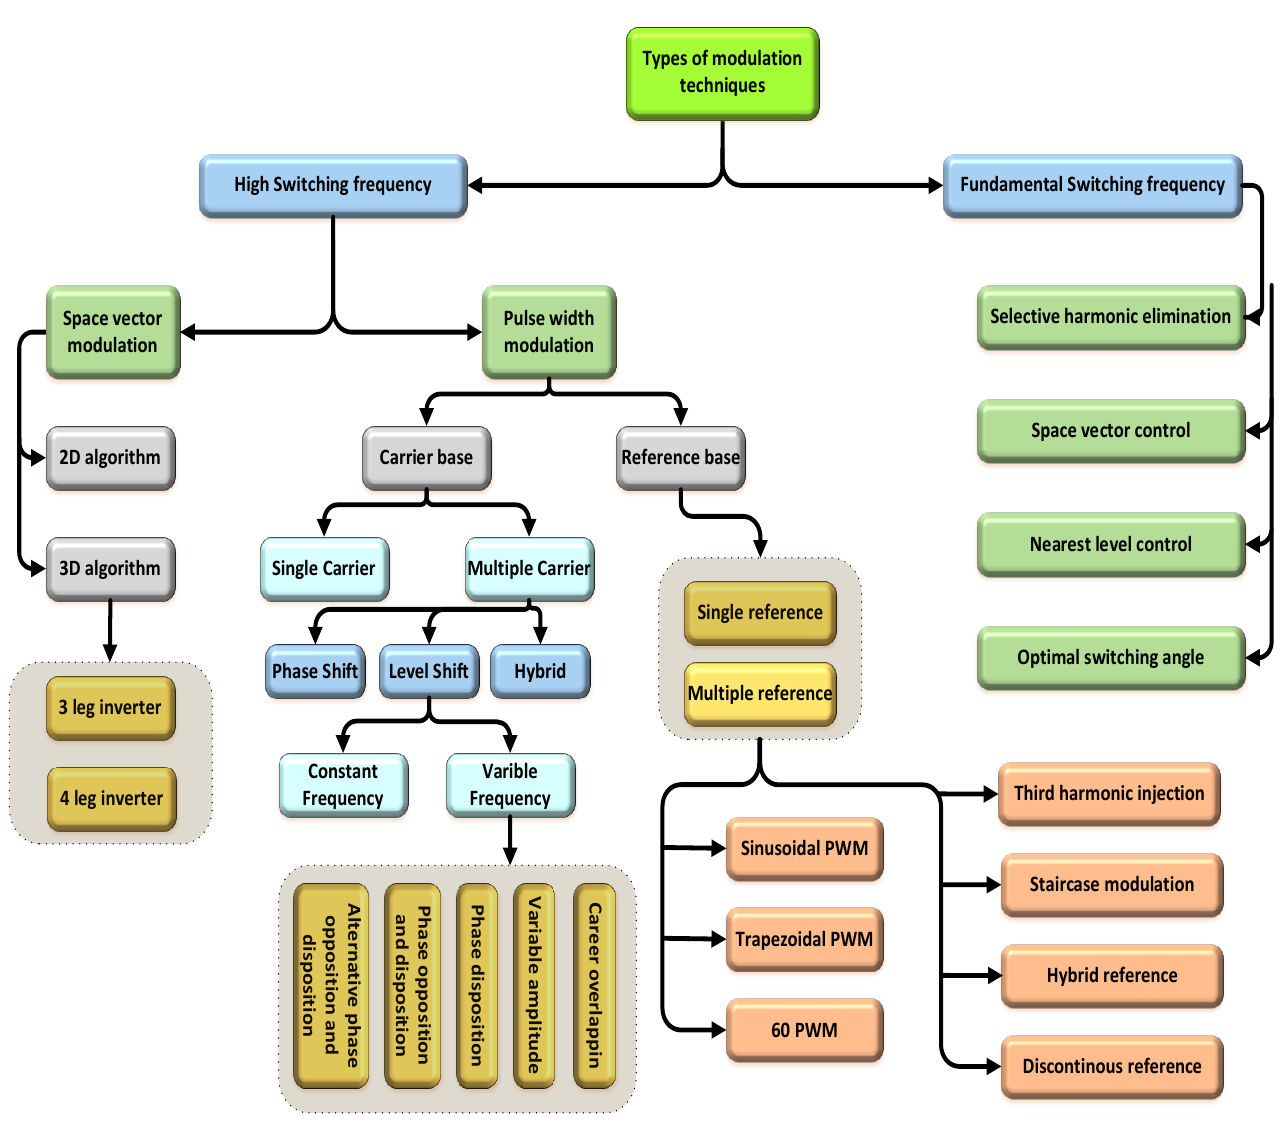
Figure 10. Taxonomy tree of different MTs [53].